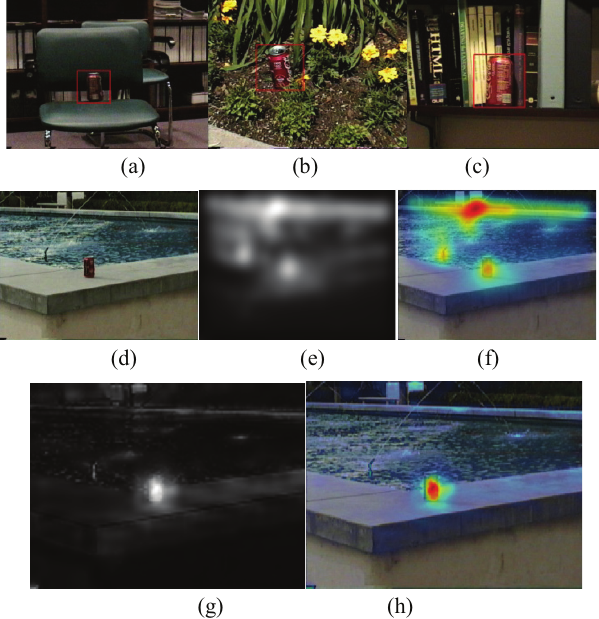
Fig. 5. Results of Experiment 2 where our target is a can (all images are from iLab Image Databases 25 ): (a) Training image 1 (b) Training image 2 (c) Training image 3 (d) Test image (e) Itti’s saliency map (f) Itti’s saliency map represented as a heat map (g) our saliency map (h) our saliency map represented as a heat